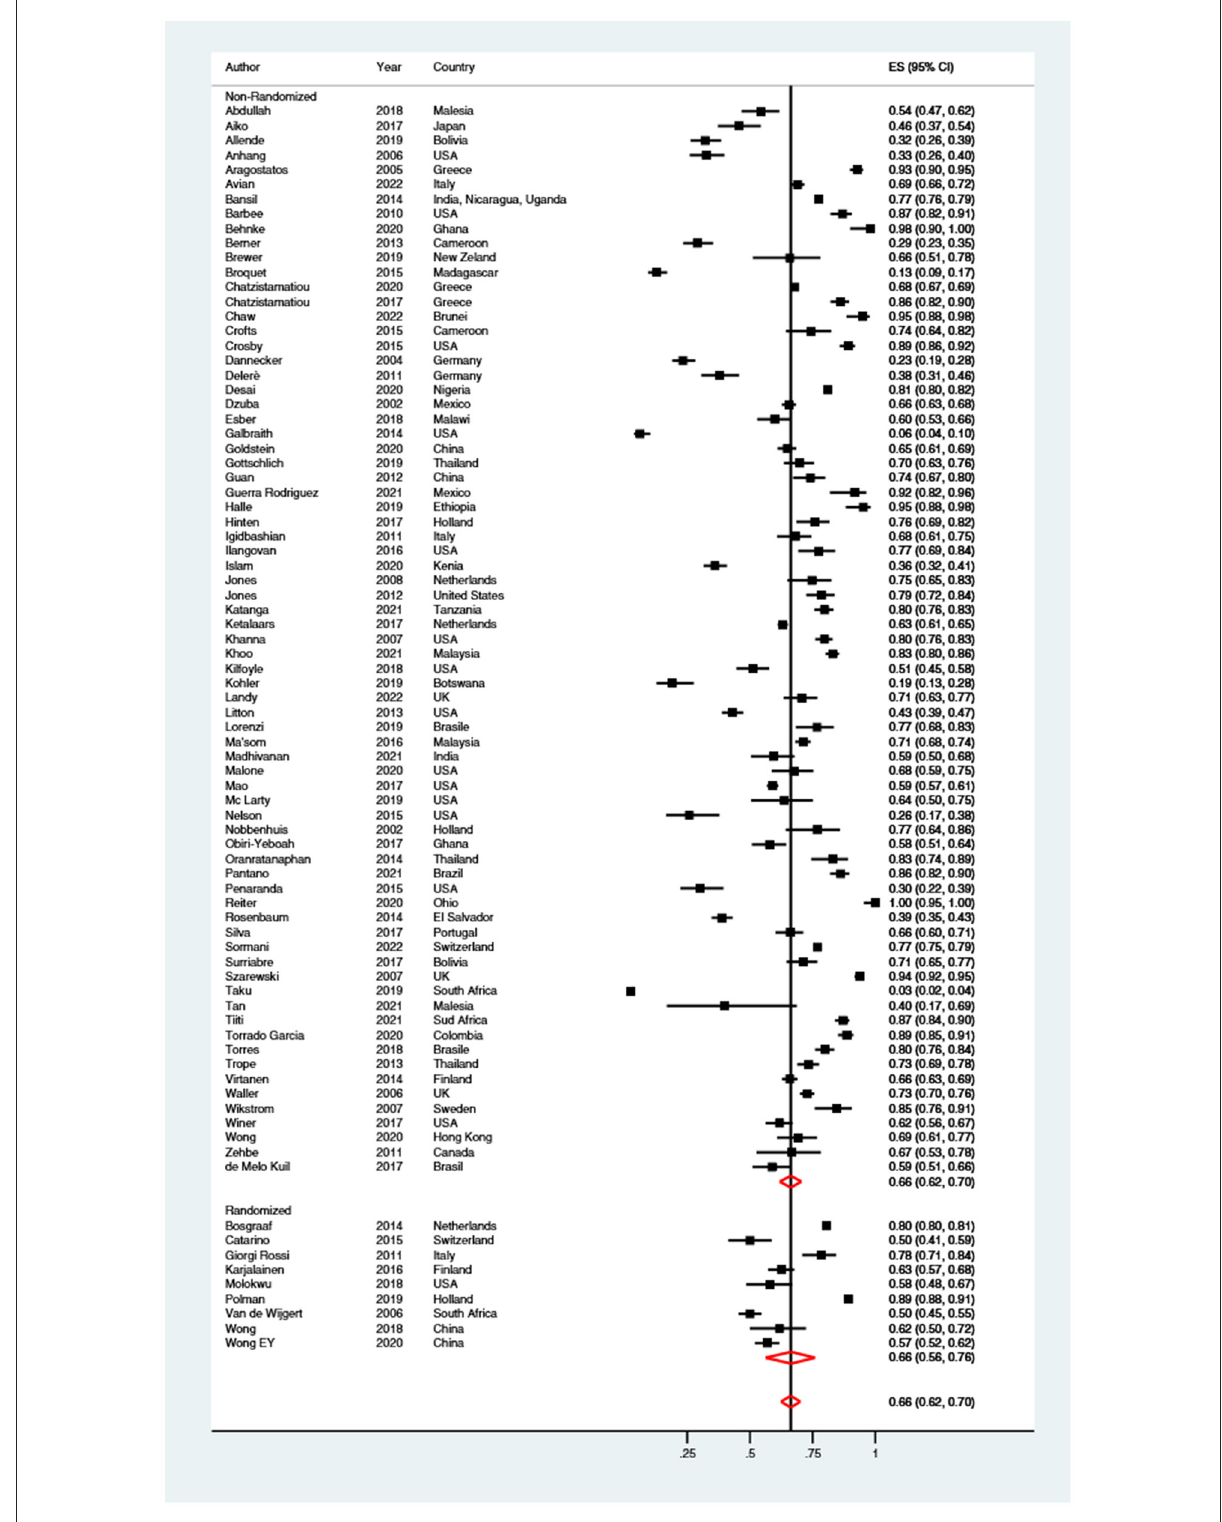
FIGURE7 Forest plot of the proportion of women preferring self-sampling over clinician-collected samples. Homogeneity ( I -squared): 99.0%; Cochrane’s Q test for between-group differences: Q = 7,842.51; df = 81; p <